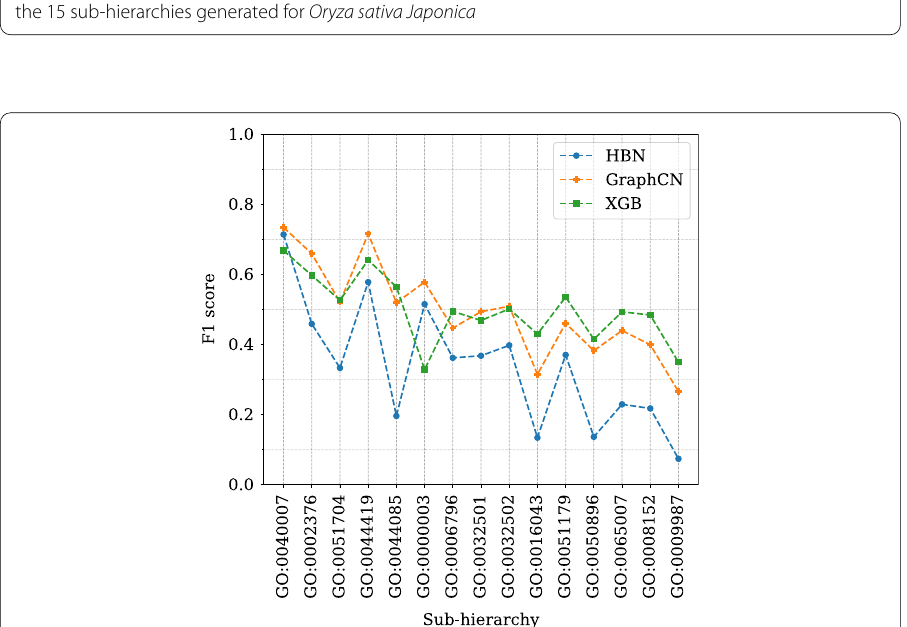
Fig. 6 F1 score of the hierarchical multi-label classification approach with XGBoost (XGB) and graph convolutional network (GraphCN) classifiers, and the HBN model for the 15 sub-hierarchies generated for Oryza sativa